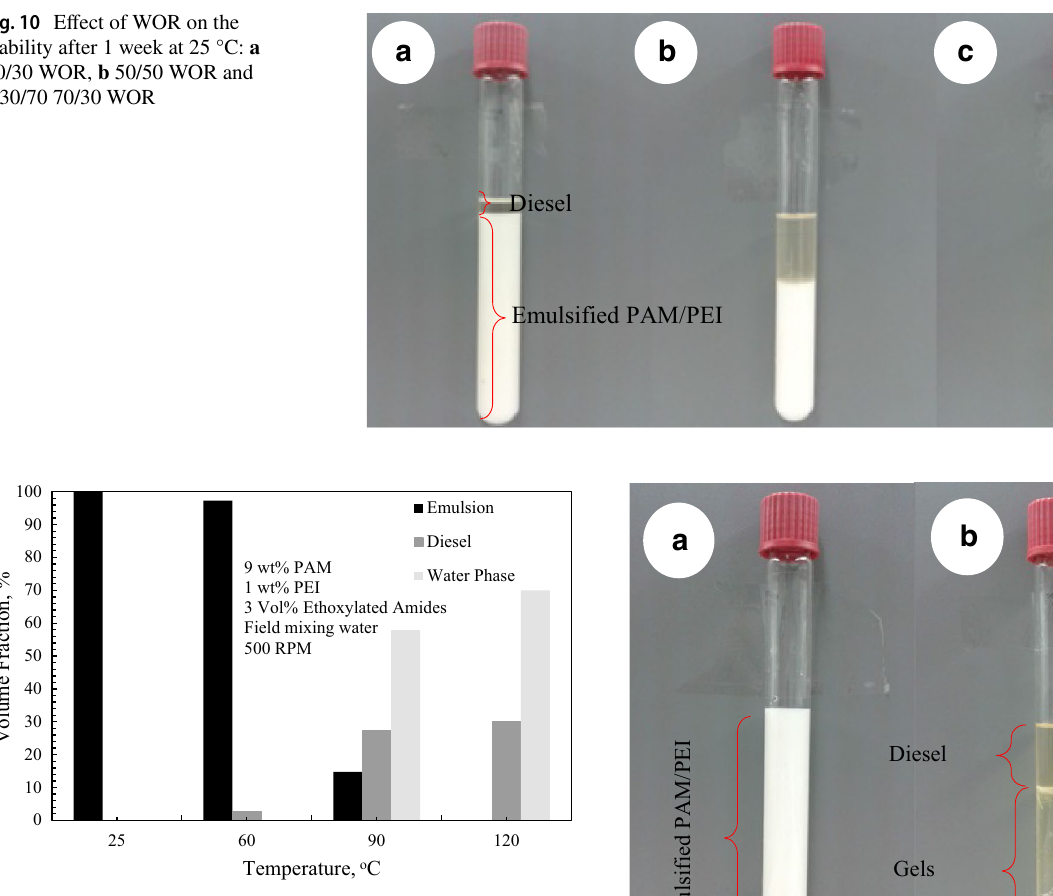
Fig. 11 Volume fraction of the emulsified gels at different tempera- tures after 1 h